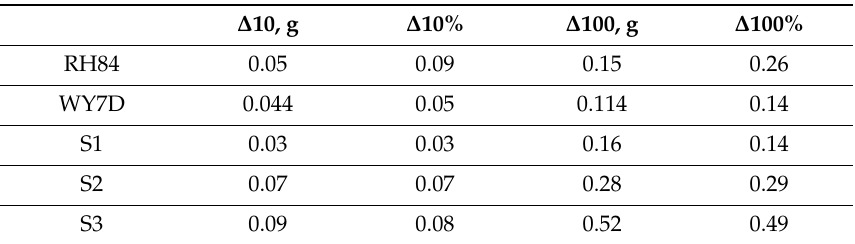
Table 2. Loss in brush weight after sliding.